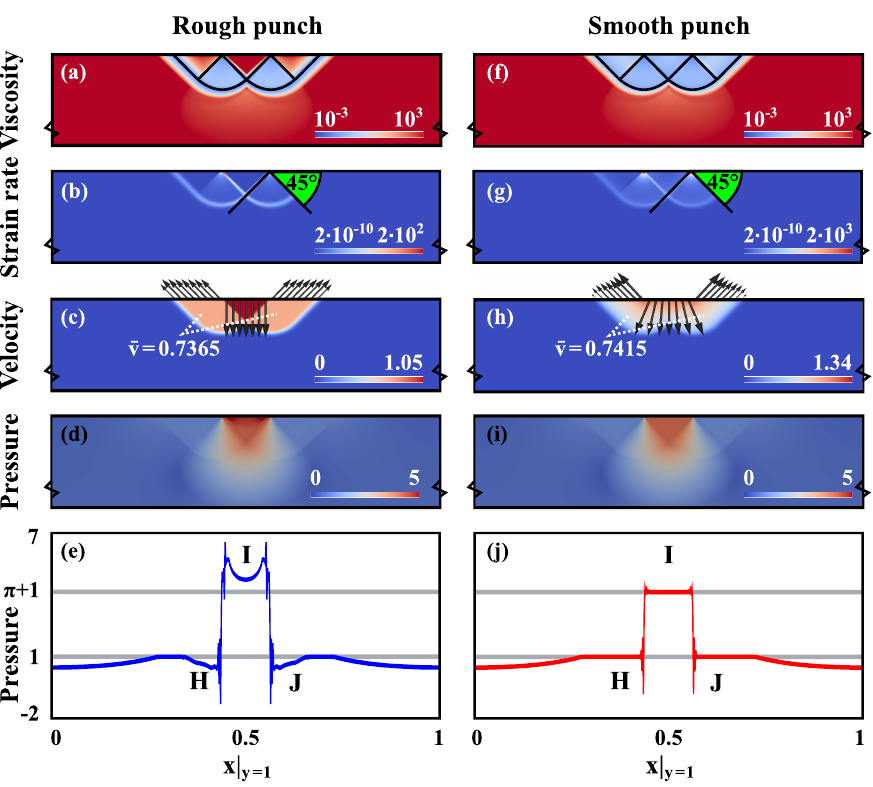
Figure 3. The punch benchmark results after 500 NIs for a rough punch (left column) and a smooth punch (right column). (a, f) Viscosity √ ˙ (cid:15) : ˙ (cid:15) ) with measured shear band angles. (c, h) Velocity magnitude with velocity field with analytical slip lines. (b, g) Strain rate norm ( vectors along the surface of the domain and velocity measurements in points K and L. (d, i) Pressure field. (e, j) Pressure along the surface of the domain (colored line) and analytical solution values π + 1 and 1 (grey lines). Rough punch: P I = 4 . 7382 and P H = P J = 0 . 6224. Smooth punch: P I = 4 . 1415 and P H = P J = 0 .